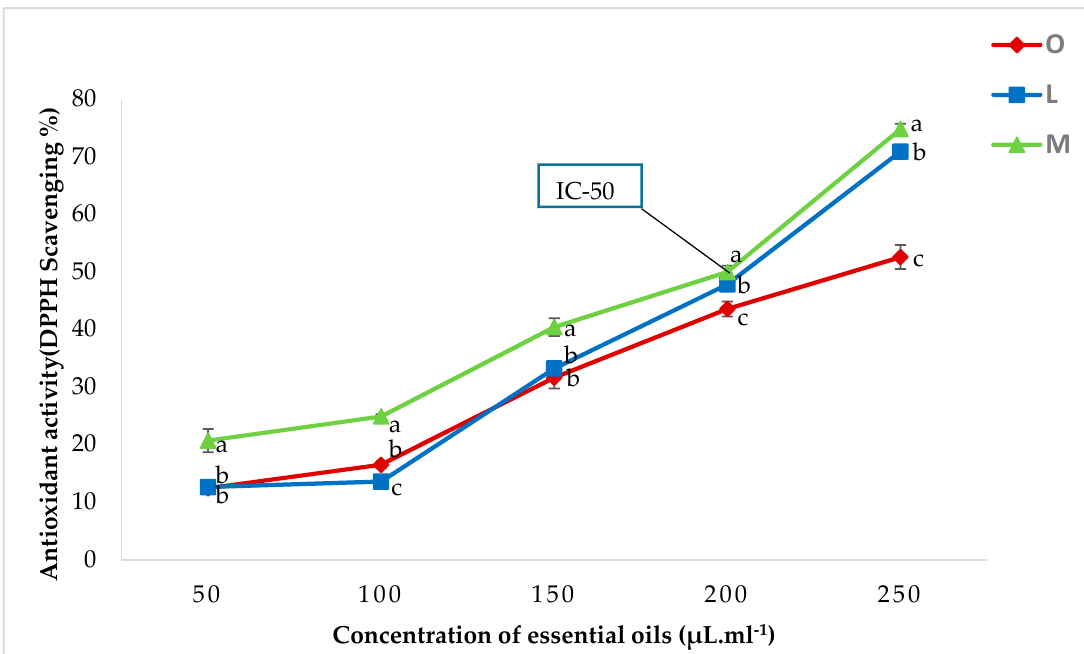
Figure 1. Percentage free radical scavenging activity and IC50 of citrus peel essential oils (L = lemon, O = orange, and M = mandarin essential oil). Vertical bars indicate standard deviation (n = 3). Means and different letters indicate significant difference between essential oils at each concentration (Duncan’s of 95%).